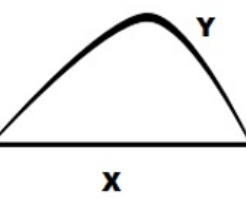
Figure 2. Trajectory of the center of mass in jump flying distance.